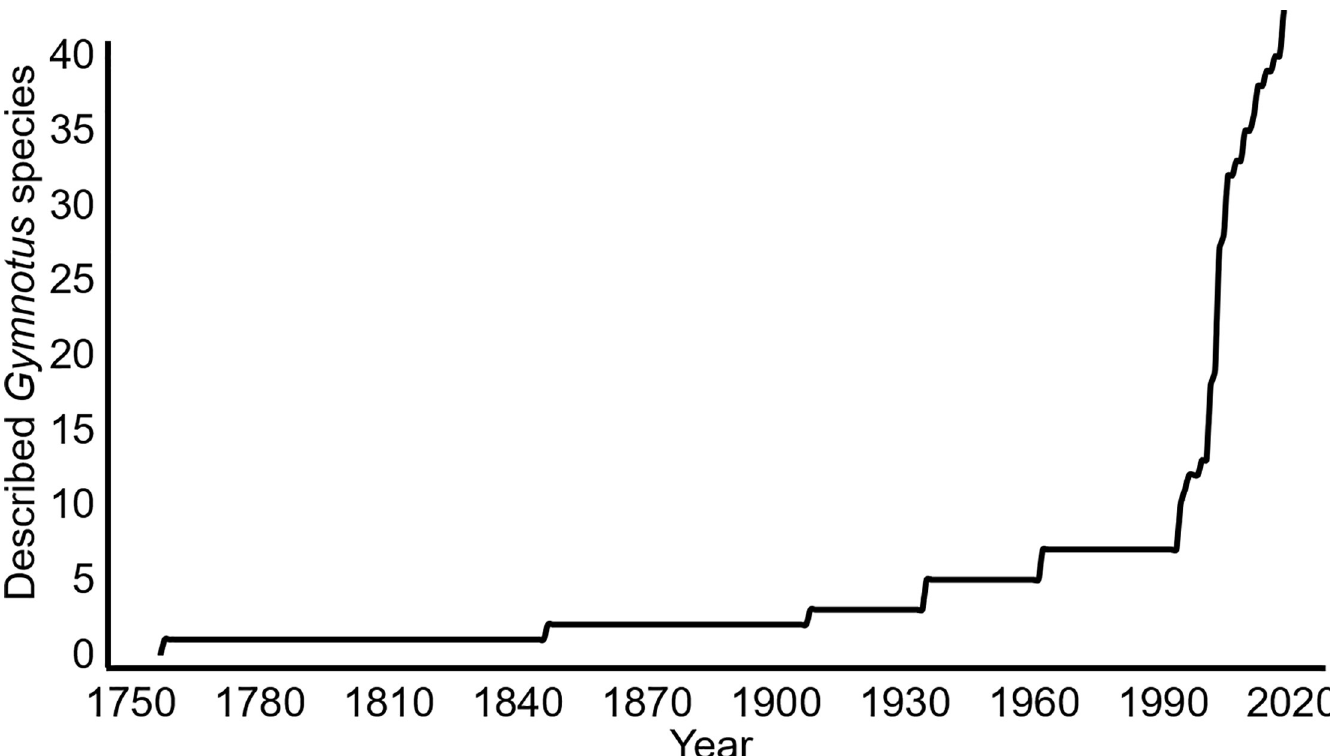
Fig 1. Timeline for the description of new gymnotine species, starting with G . carapo (Linnaeus) in 1758. Note the rapid acceleration species descriptions in the last three decades, similar to that observed in many clades of Neotropical freshwater fishes.